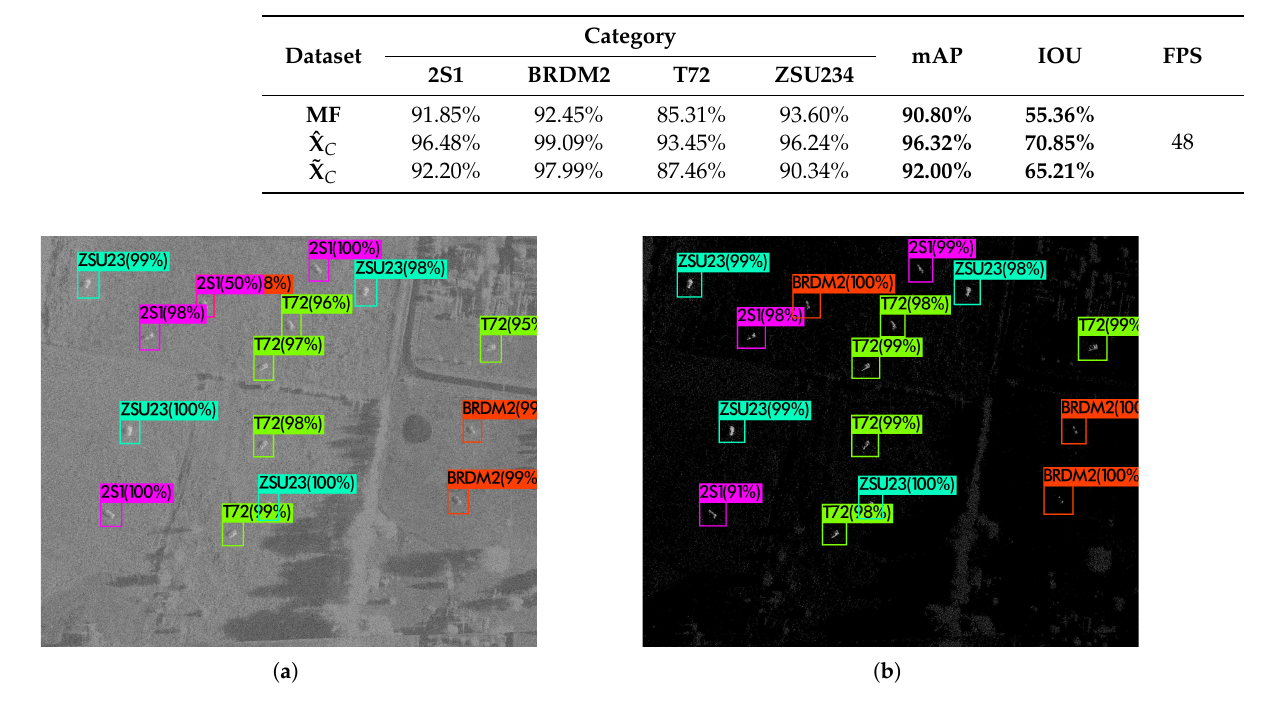
Table 8. Target detection under EOC.